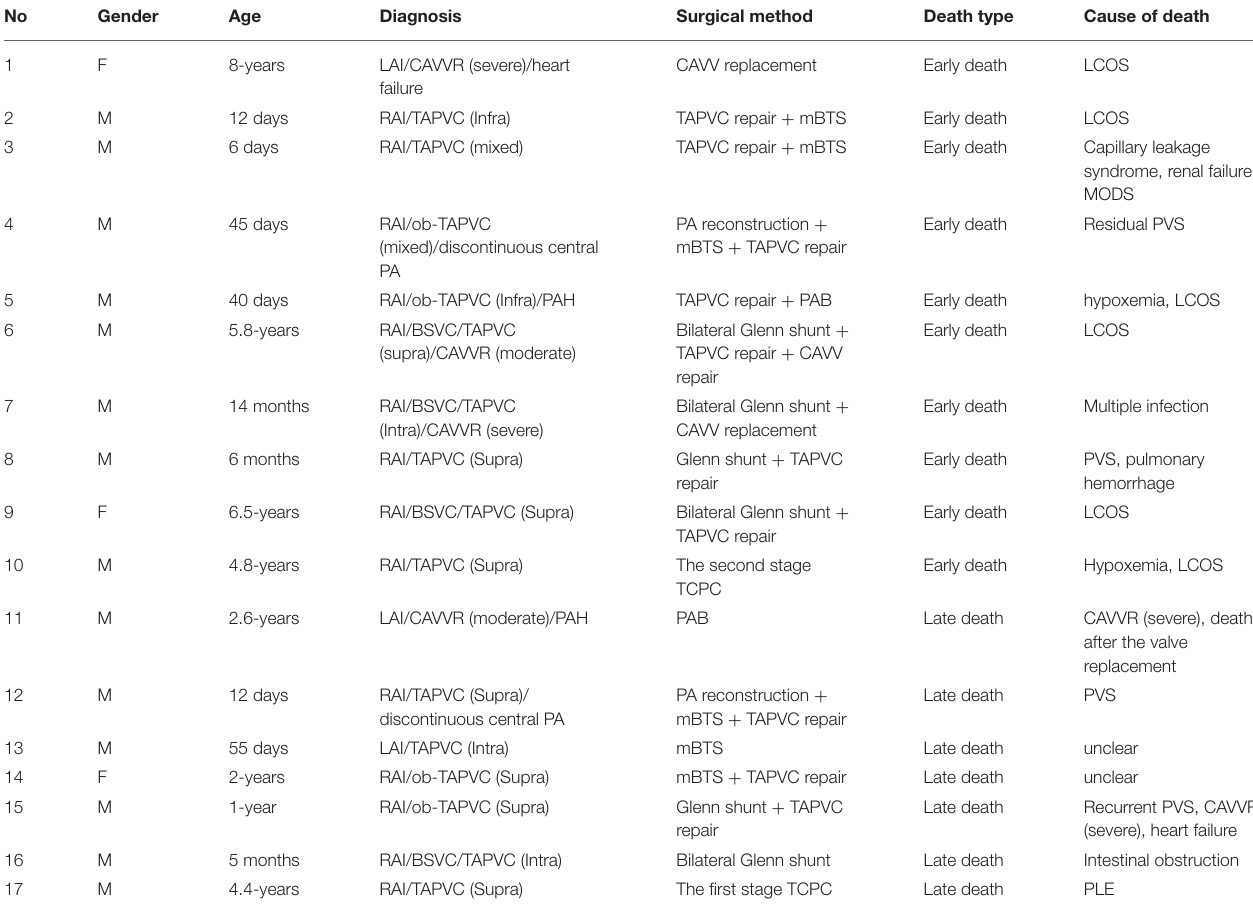
TABLE 2 | The details of all death cases ( n = 17).